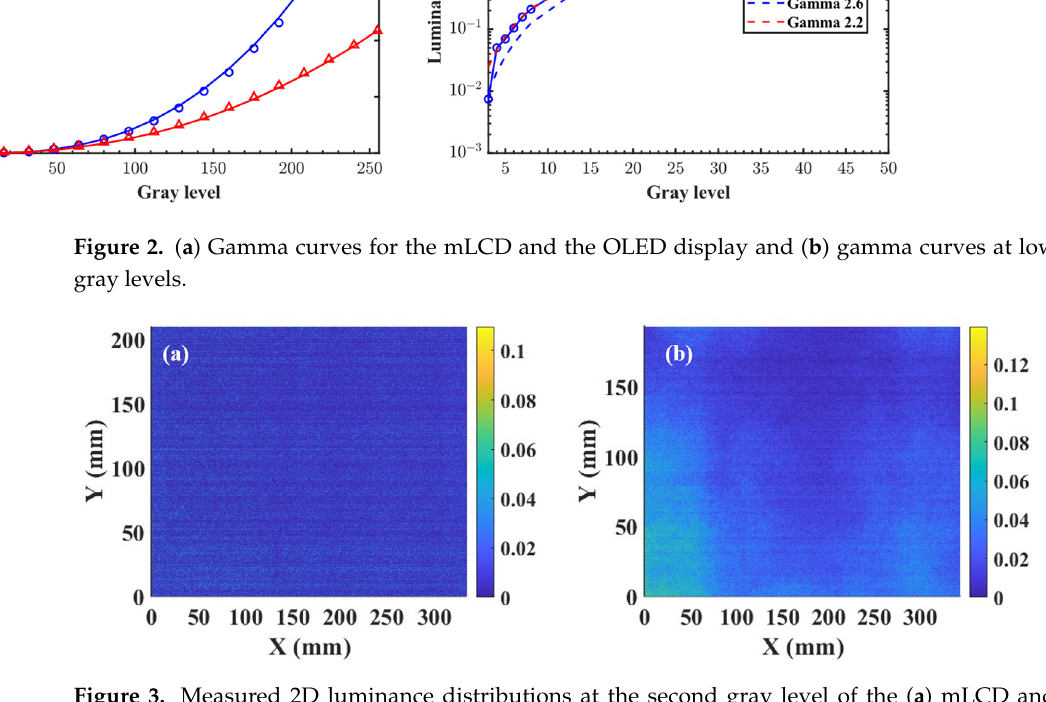
Figure 3. Measured 2D luminance distributions at the second gray level of the ( a ) mLCD and ( b ) OLED panels.